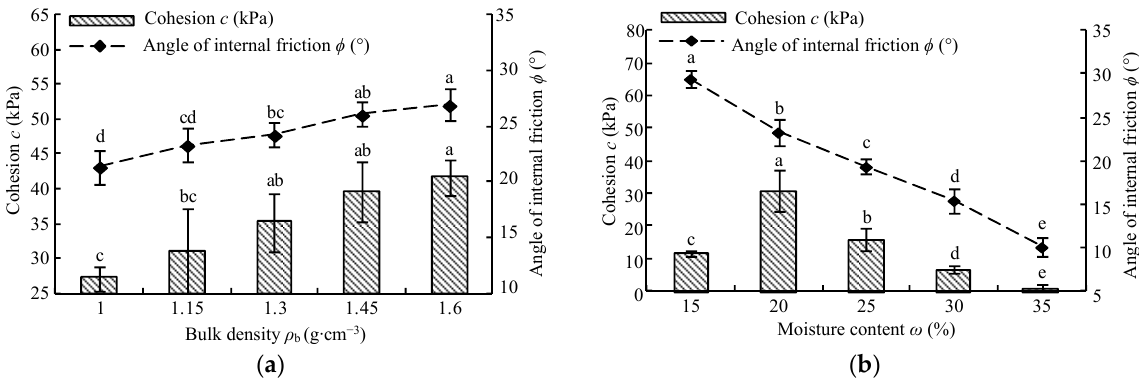
Figure 3. Changes in paddy soil cohesiveness between treatments: ( a ) variation of paddy soil in bulk density, and ( b ) variation of paddy soil in moisture content.